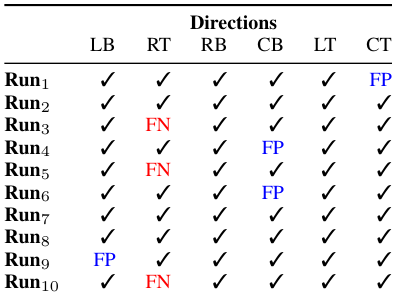
Fig. 14: Latency between the recognized gestures using the Leap Motion and the visualized gestures displayed in the computer